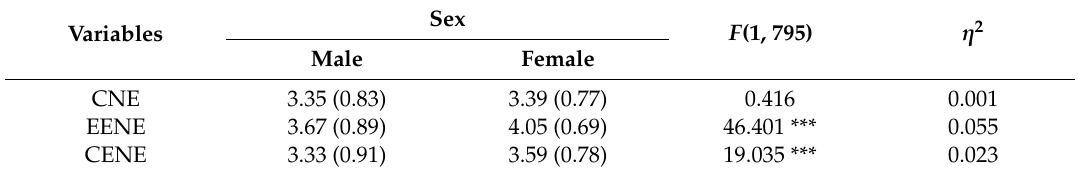
Table 4. Means (standard deviations), and main univariate F values for gender and connectedness to the natural environment, emotional empathy to natural environment, and cognitive empathy for natural